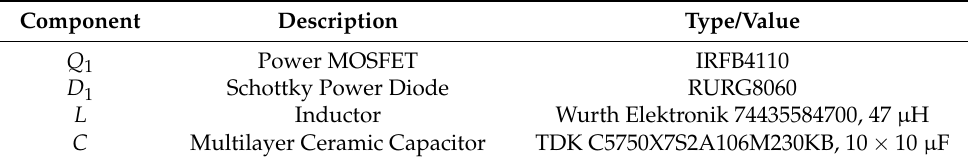
Table 1. Description of the boost converter’s components.